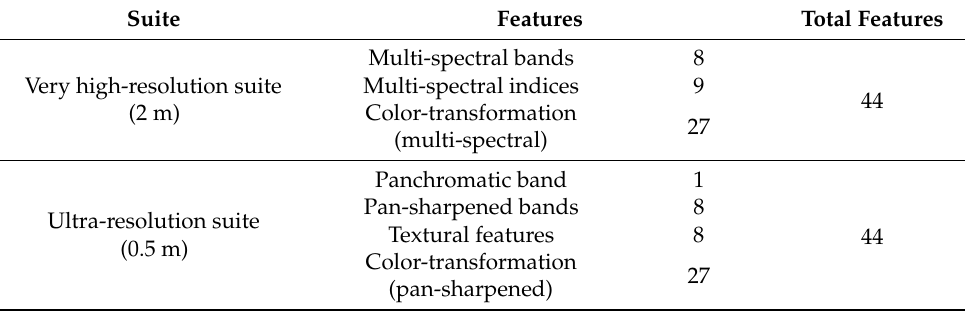
Table 2. Description of the features extracted for very high-resolution and ultra-resolution map- ping